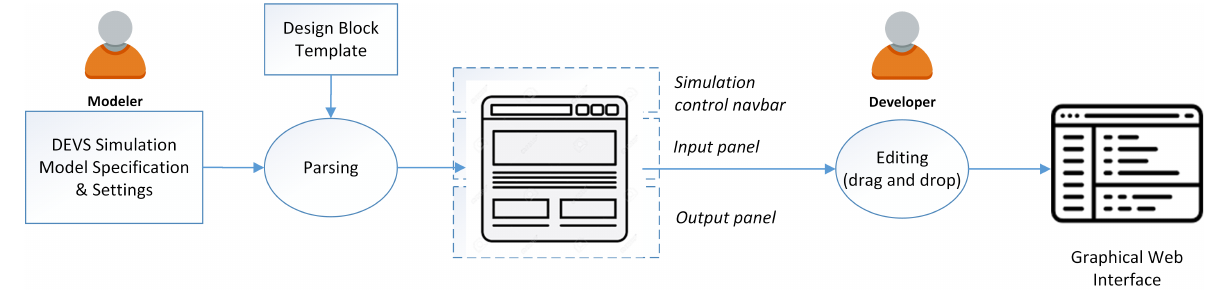
Figure 8. Web interface-building from the DEVS simulation model to graphical web interface (web app). The parsing process uses design block templates to generate the web app in a quasi-automatic way. The developer can refine the web app interface using a back-office editor that allows, among other things, the drag and drop of HTML components. The socket-based JS engine in charge of bidirectional communication does not require